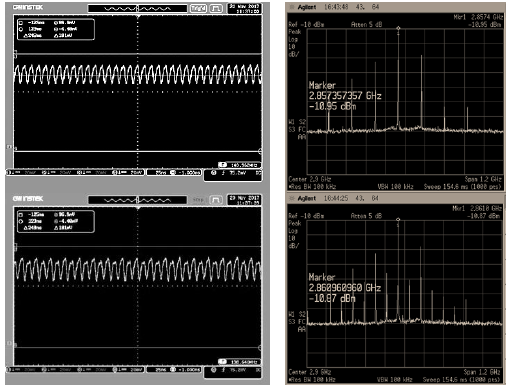
Fig. 9. The cascade of bifurcations of doubling the envelope modulation band of mutual detunings of the order of 10-15 MHz. Figure 9 shows a typical sequence of changes in the envelope of the signal of the total load and its spectrum